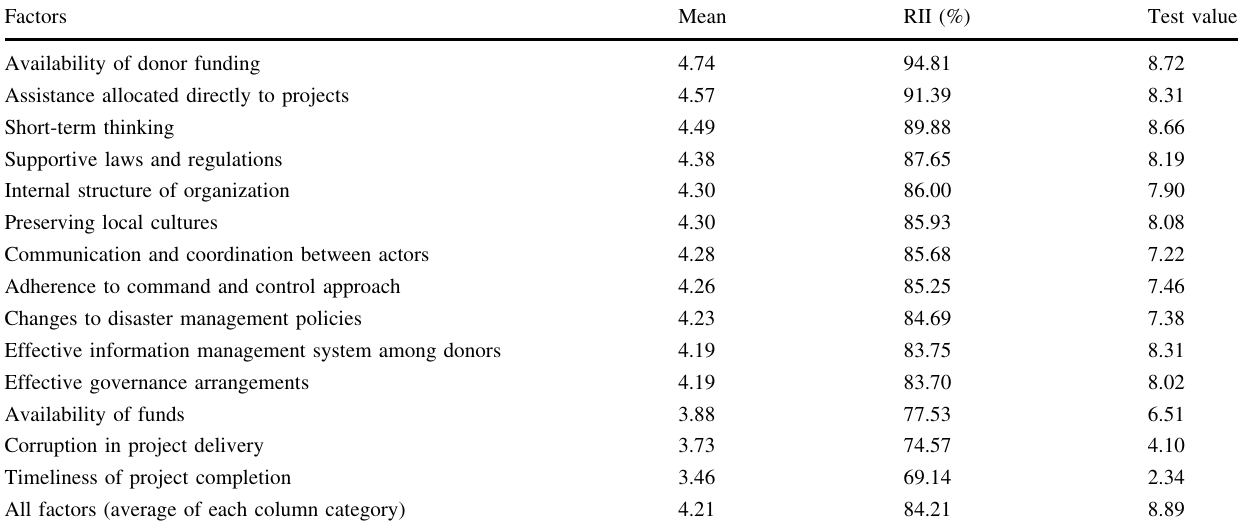
Table 7 Factors influencing the PDRPM context in the Gaza Strip